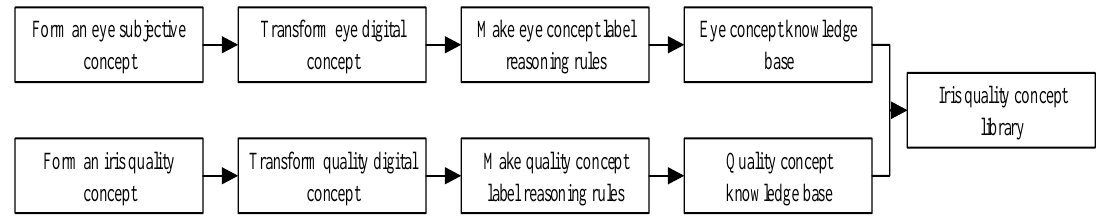
Figure 7. The operation process of iris quality knowledge concept construction mechanism.